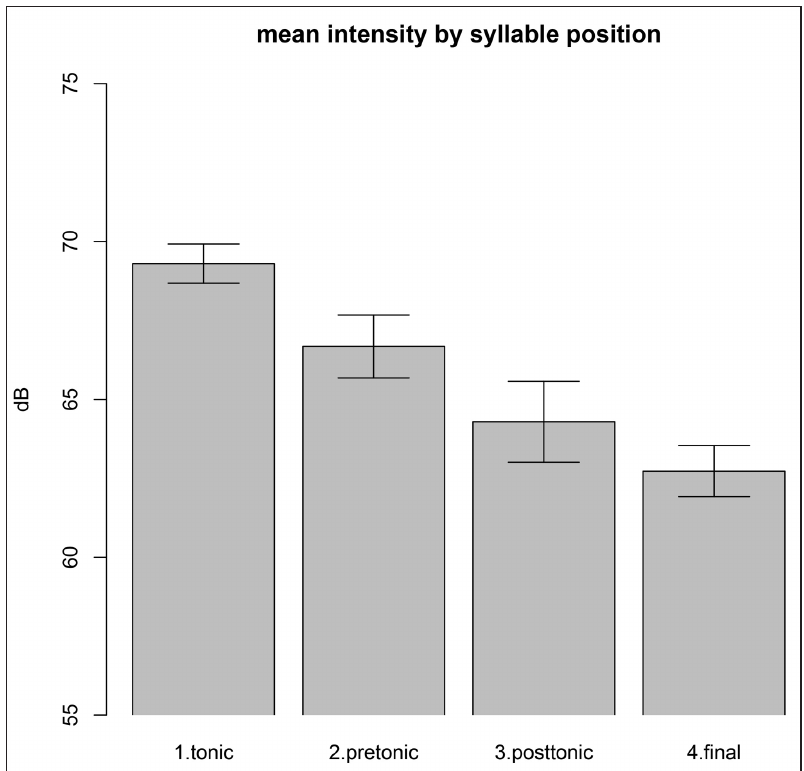
Figure 2: Mean intensity (dB) of the vowel nucleus in four syllable positions from set A. Error bars are 95% confidence